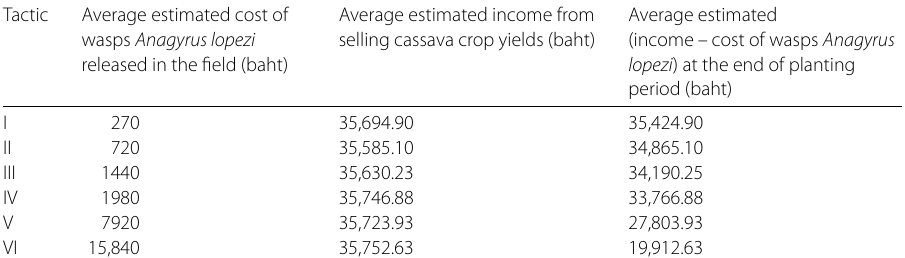
Table 3 The average estimated cost of wasps Anagyrus lopezi released in the field, the average estimated income from selling cassava’s crop yields, and the average estimated (income – cost of biological control agents) at the end of planting period for each tactic Tactic Average estimated cost of Average estimated income from Average estimated wasps Anagyruslopezi selling cassava crop yields (baht) (income – cost of wasps Anagyrus released in the field (baht) lopezi ) at the end of planting period